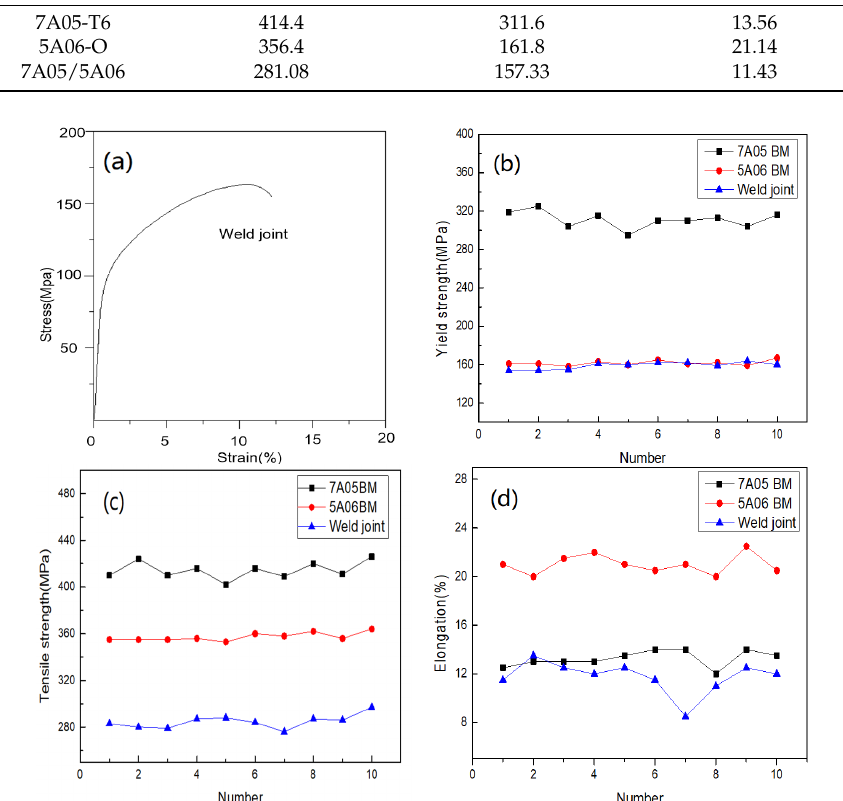
Figure 6. Mechanical properties of the sample: ( a ) tensile stress-strain curves of the sample; ( b ) yield stress of 5A06BM, 7A05BM and joint; ( c ) tensile stress of 5A06BM, 7A05BM and joint; ( d ) elongation of 5A06BM, 7A05BM and